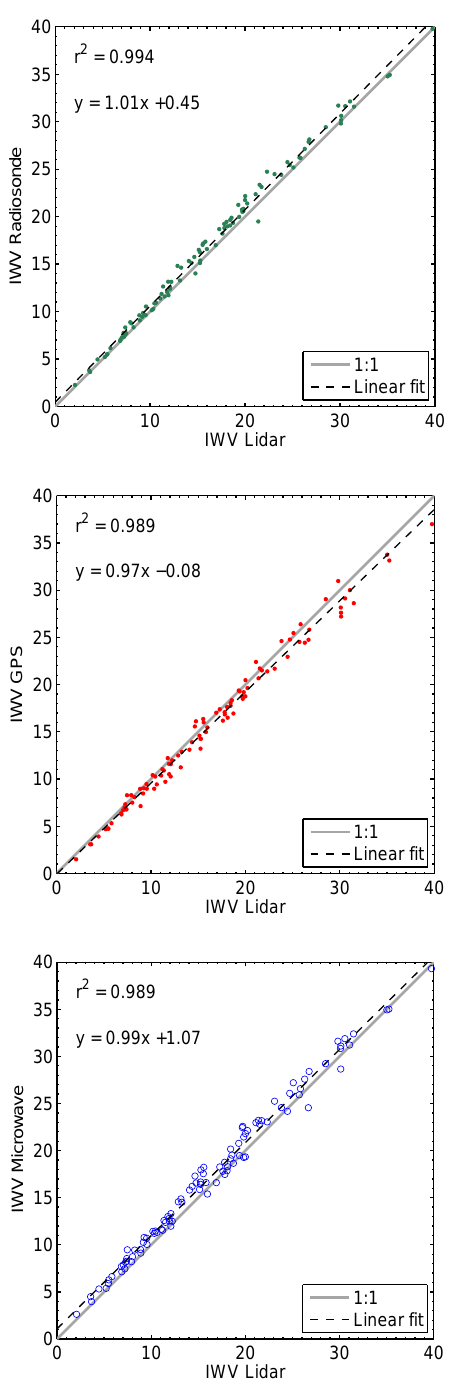
Fig. 11. Integrated Water Vapor (IWV) scatter plots between lidar and radiosondes (top), GPS (middle) and Microwave Radiometer (bottom). Linear fit are shown with dashed lines, while 1:1 guides are shown with solid grey lines. Period: 1 October 2009 to 30 September 2010. Only lidar profiles reaching at least 8 km altitude are considered (100 profiles).